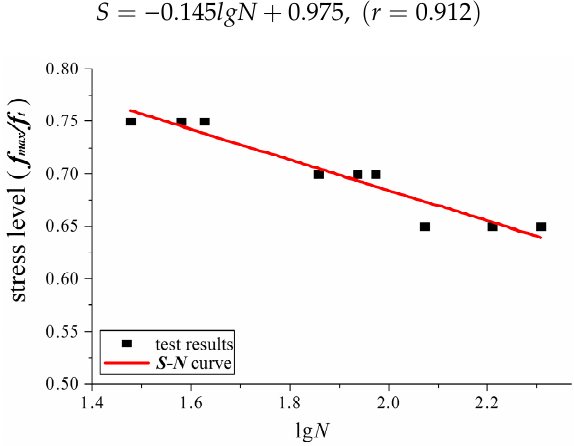
Figure 18. Least squares fitting of S–N curve fitting.